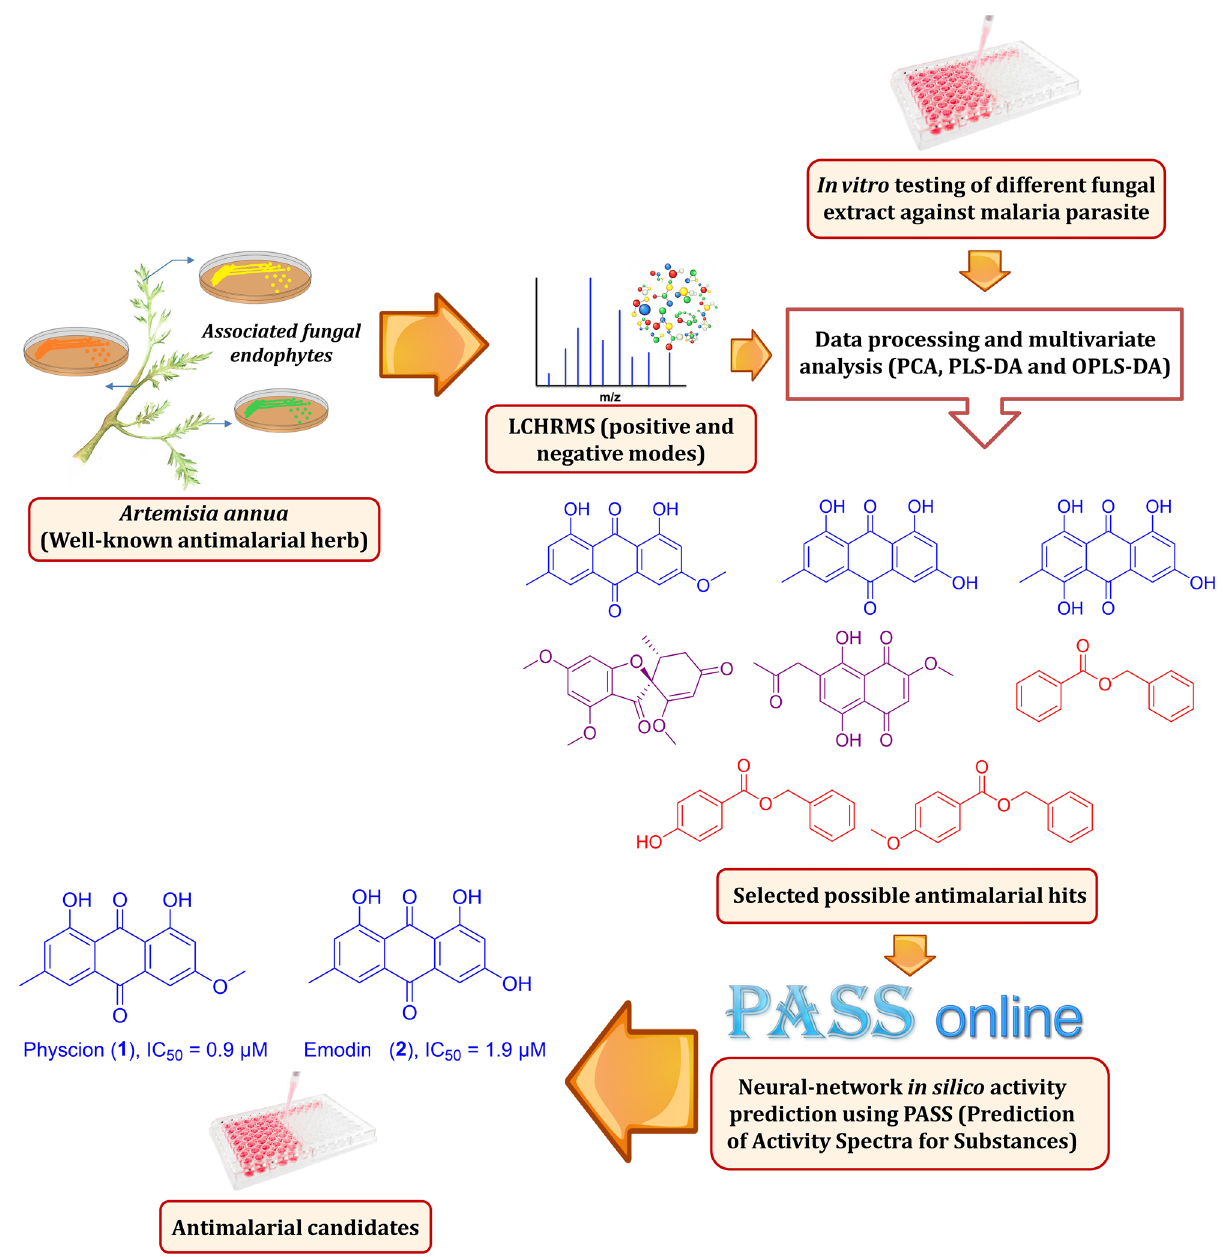
Figure 1. The applied metabolomics and in silico screening strategies in the present